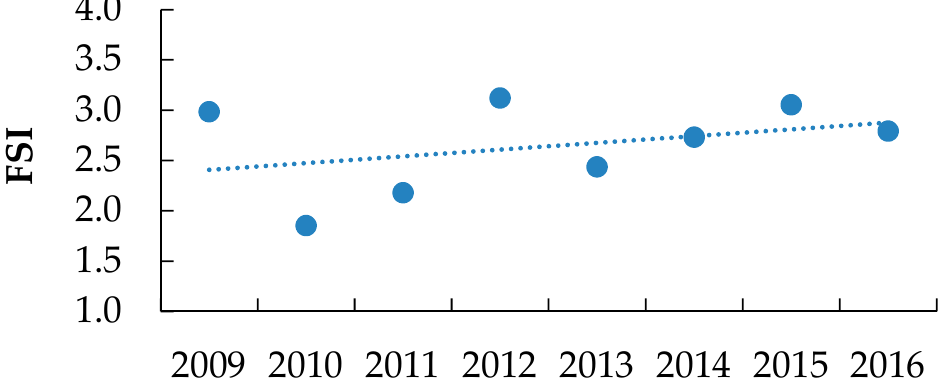
Figure 17. The severity classification of the Palestinian industrial sectors according to the FSI indicator during 2009–2016. The increasing trend in the SPF indicator (Figure 18) sheds light on the industrial manufacturing sector’s severity. Leather industries had the highest number of lost working days, with an average SPF of 145.6 working days lost/occupational accident. On the other hand, plastic industries had the lowest average SPF of 9.8, although it has the second highest